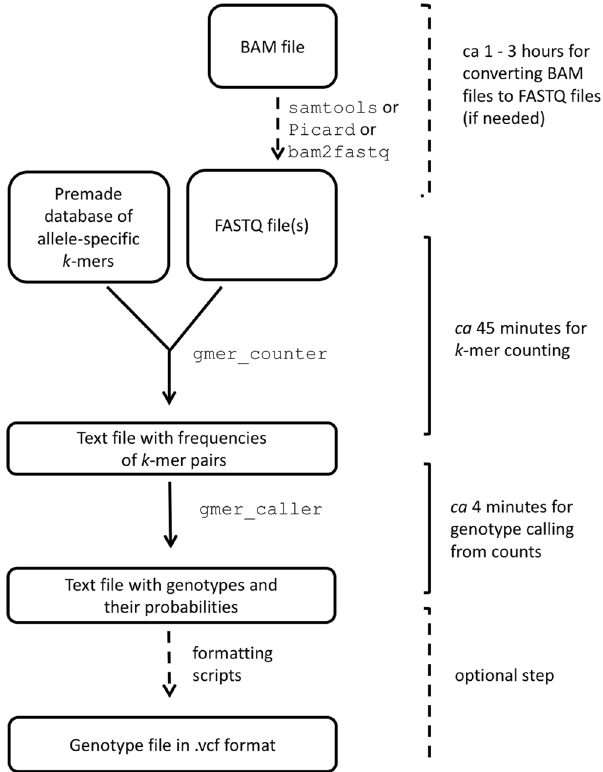
Figure 1. Overall principle of k -mer-based